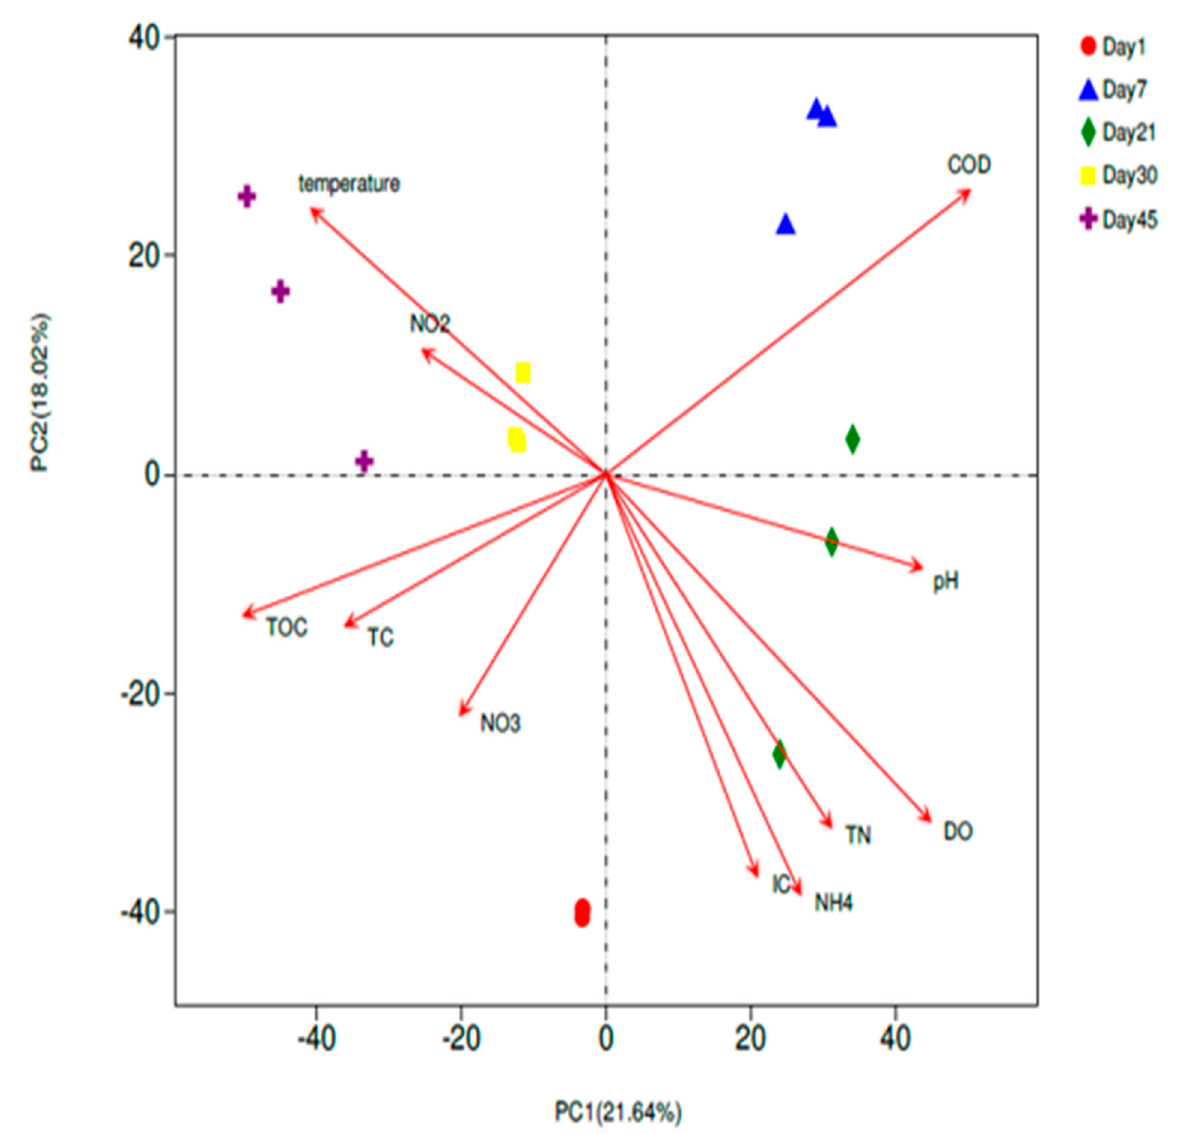
Figure 6. Principal component analysis (PCA).